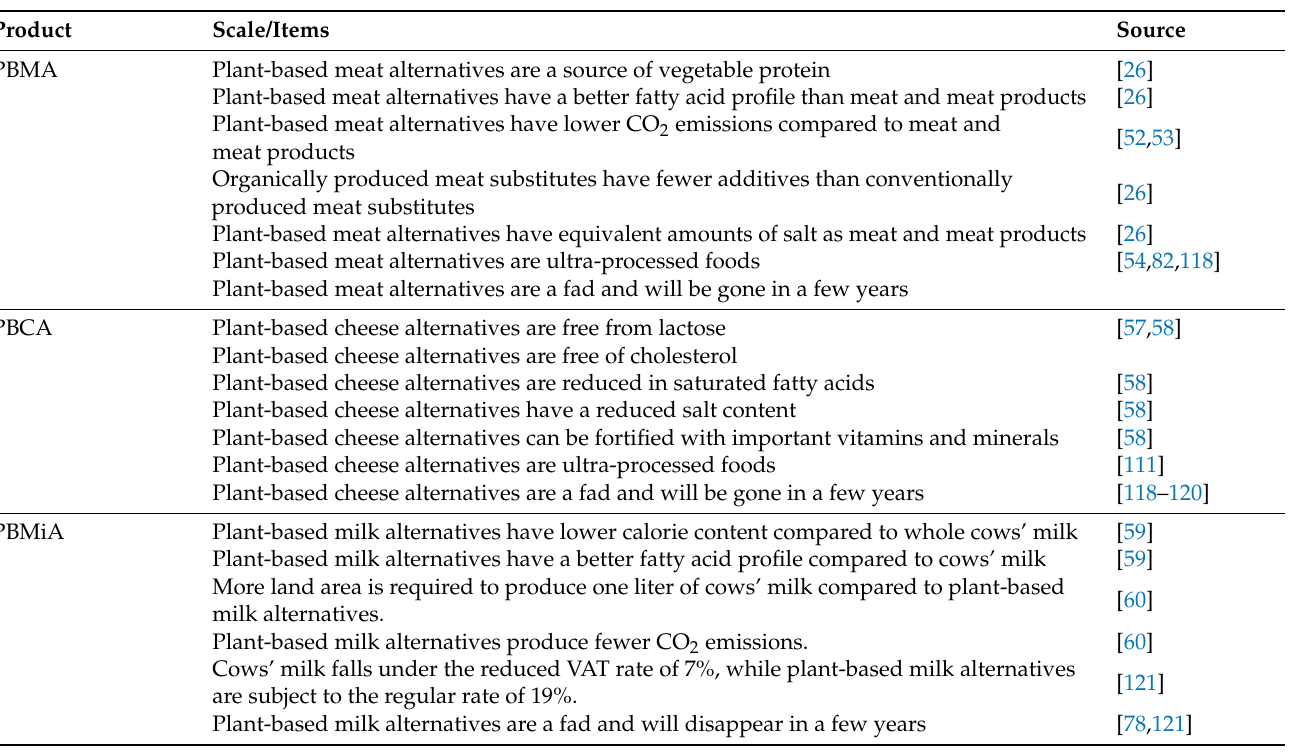
Table A2. Questionnaire items for knowledge of the respective products and